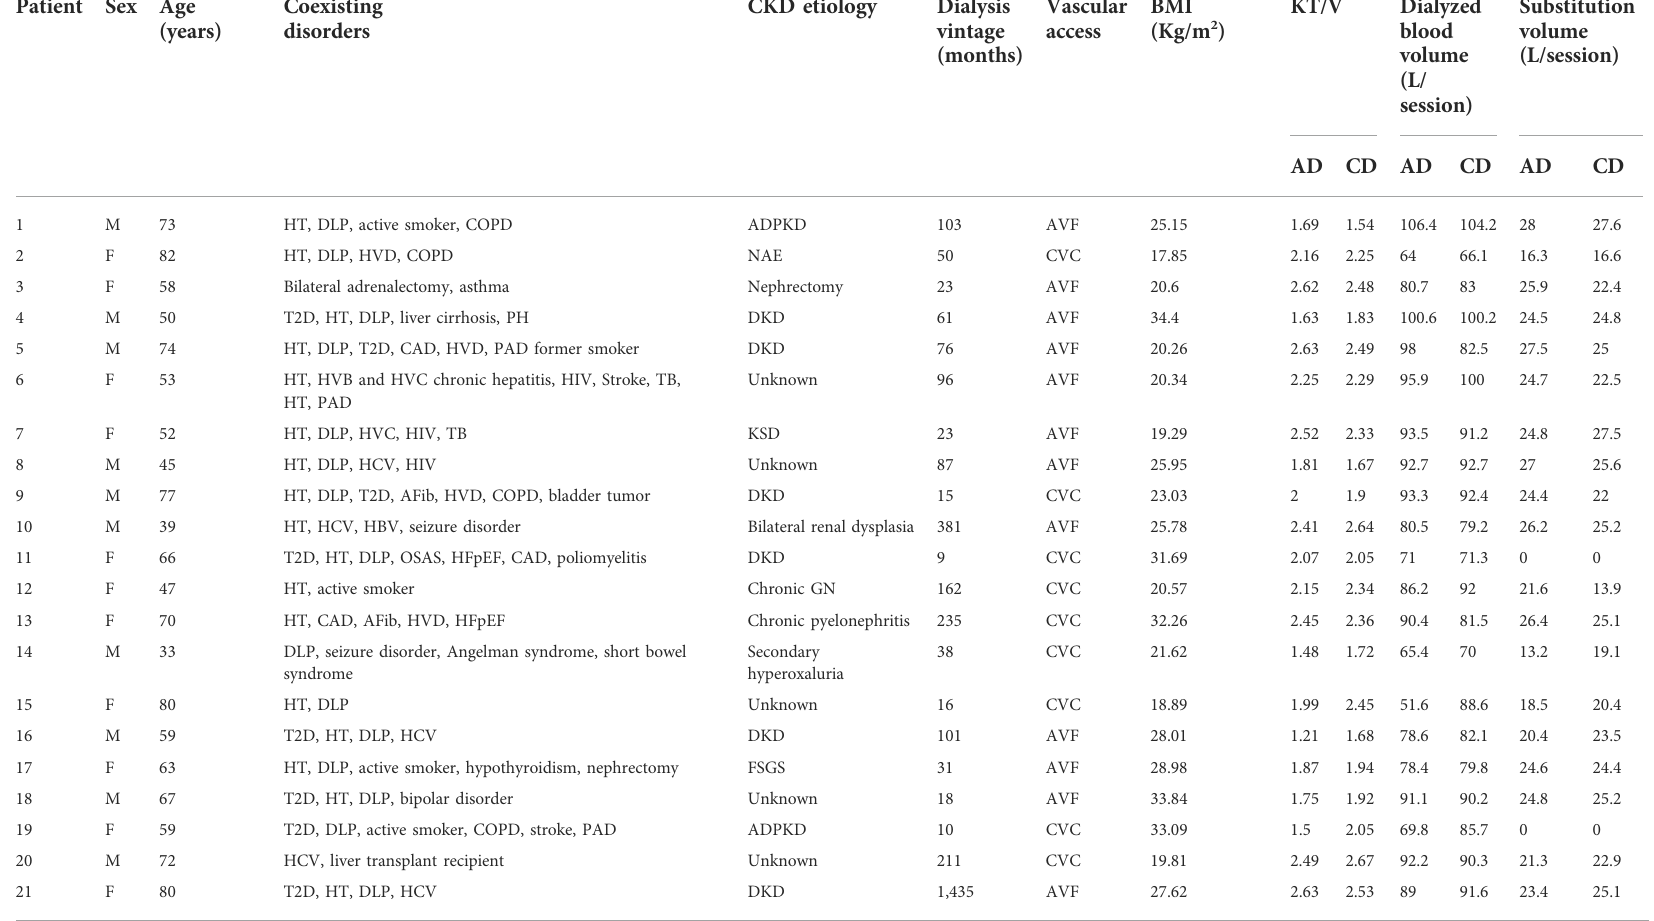
TABLE 2 Clinical characteristics and dialysis parameters of the included